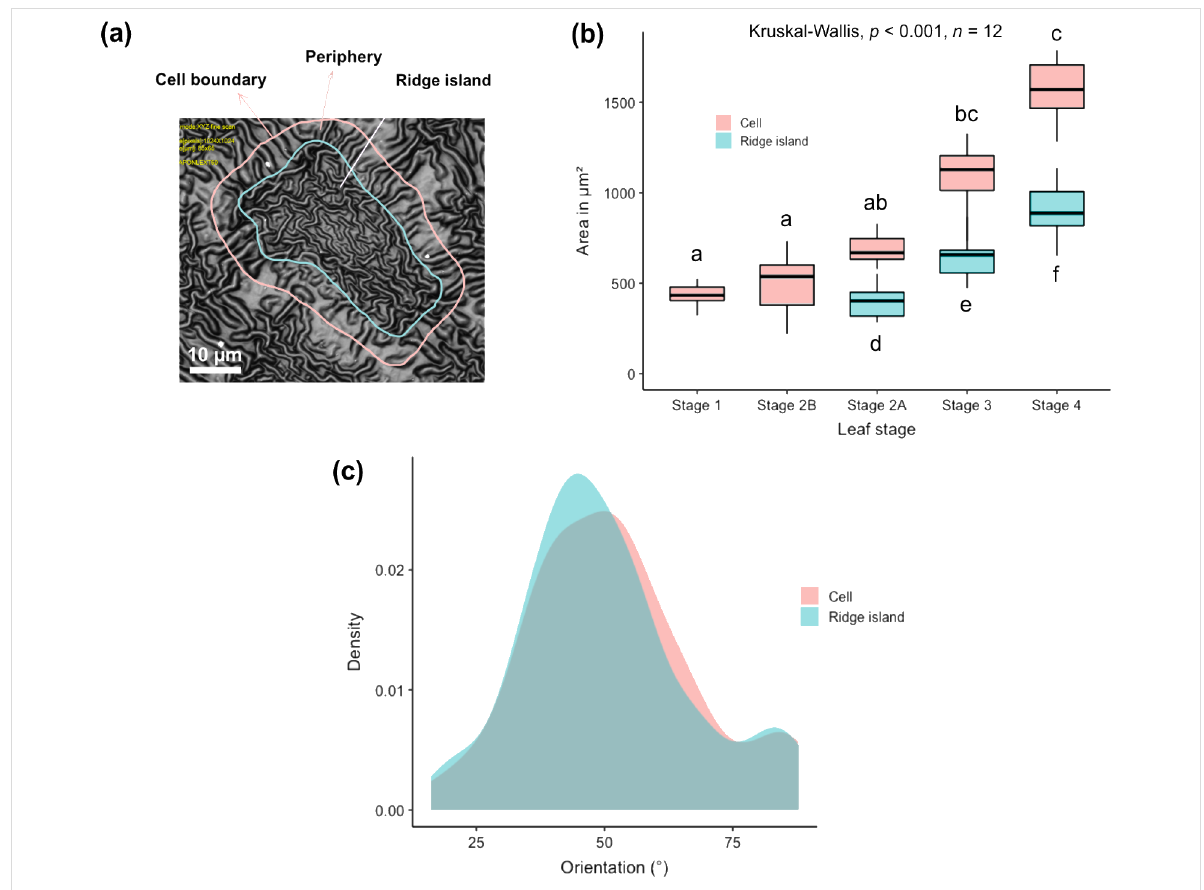
Figure 5: Cell size and orientation. (a) The outlines show the area of the epidermal cell as the sum of areas of ridge island, where the ridges are arranged in a nearly zig-zag pattern, and periphery, where the ridges are arranged nearly radially with respect to the center of the ridge island, (b) the boxplots show the increase in the area of cells (in pink) and ridge islands (in blue) with leaf growth, and (c) shows frequency density plots of orienta- tions of the long axes of cells (in pink) and ridge islands (in blue) with respect to the midrib of the leaf.